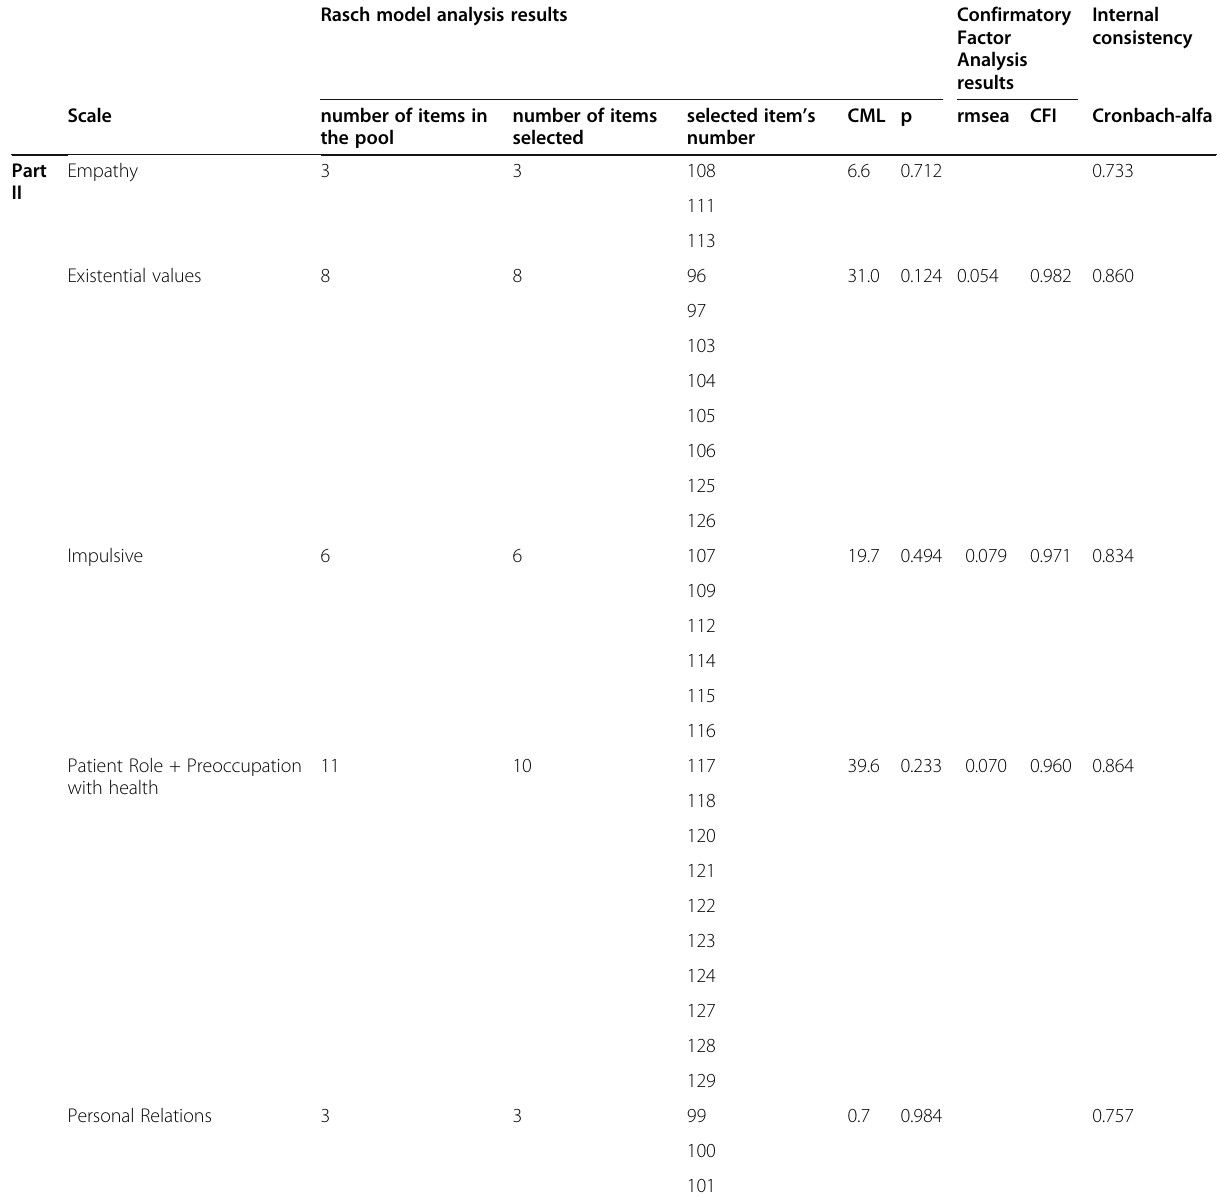
Table 5 Selected items: part II Rasch model analysis results Confirmatory